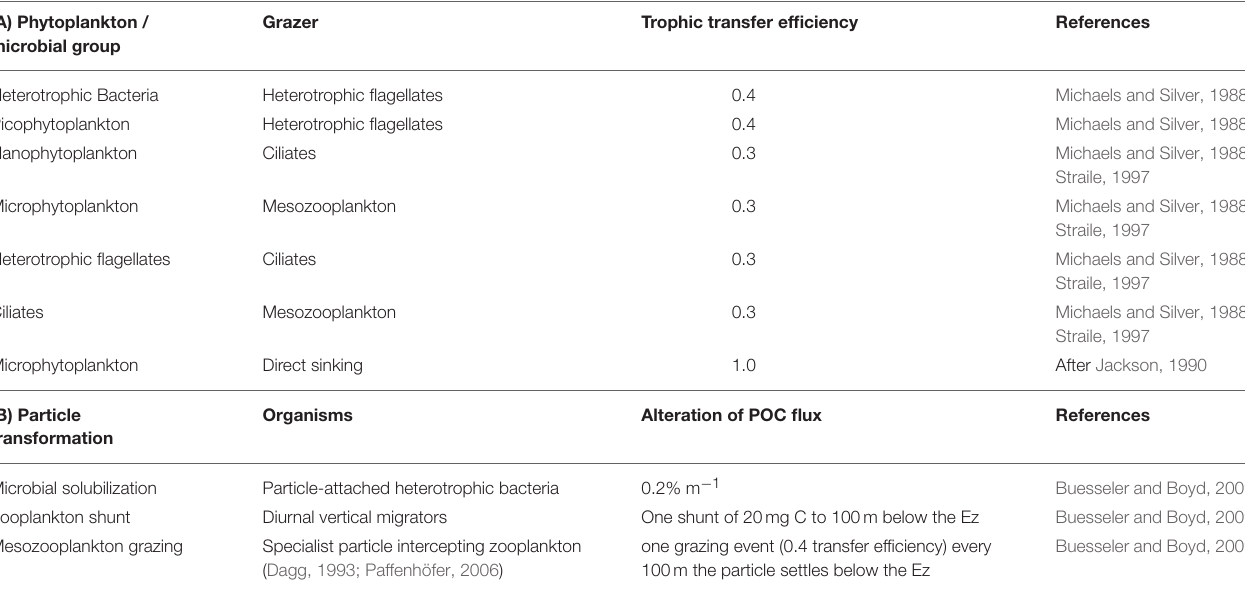
TABLE 1 | (A) Trophic transfer efficiencies through the pelagic foodweb in the surface ocean as represented by the upper panel in Figures 1, 2, and used in the control run. (B) Particle transformations in the subsurface ocean used in the control run and presented in Figure